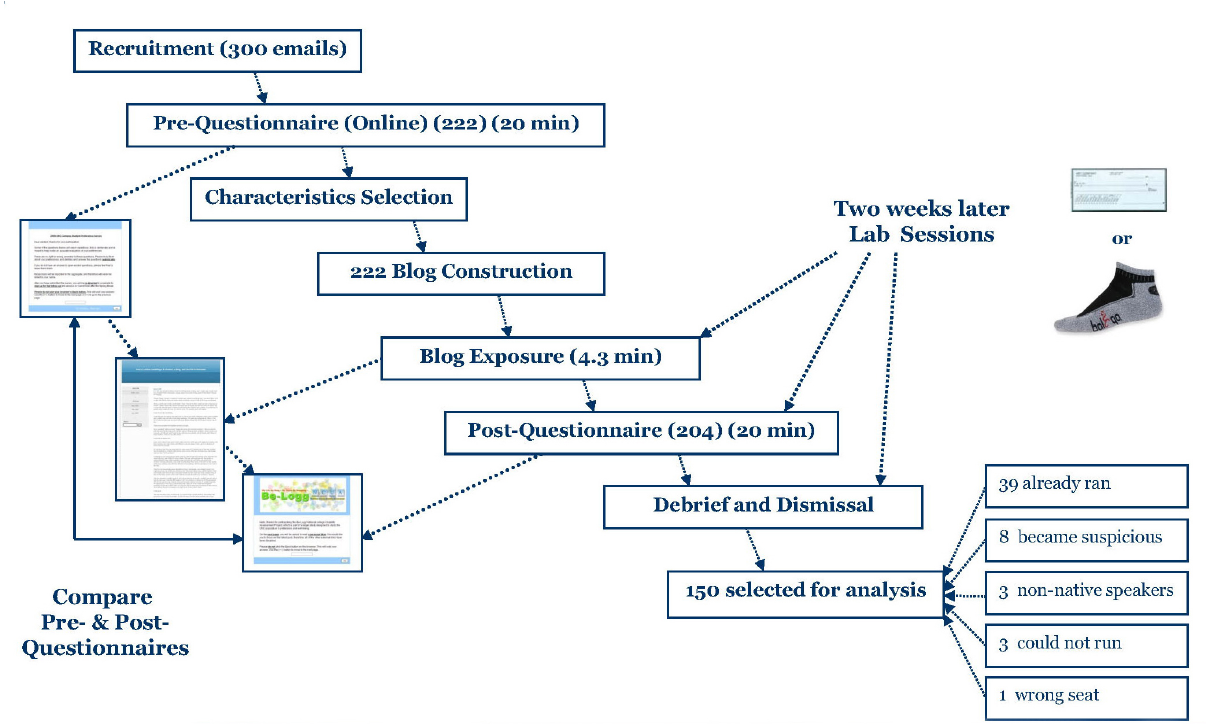
Figure 3. Experimental